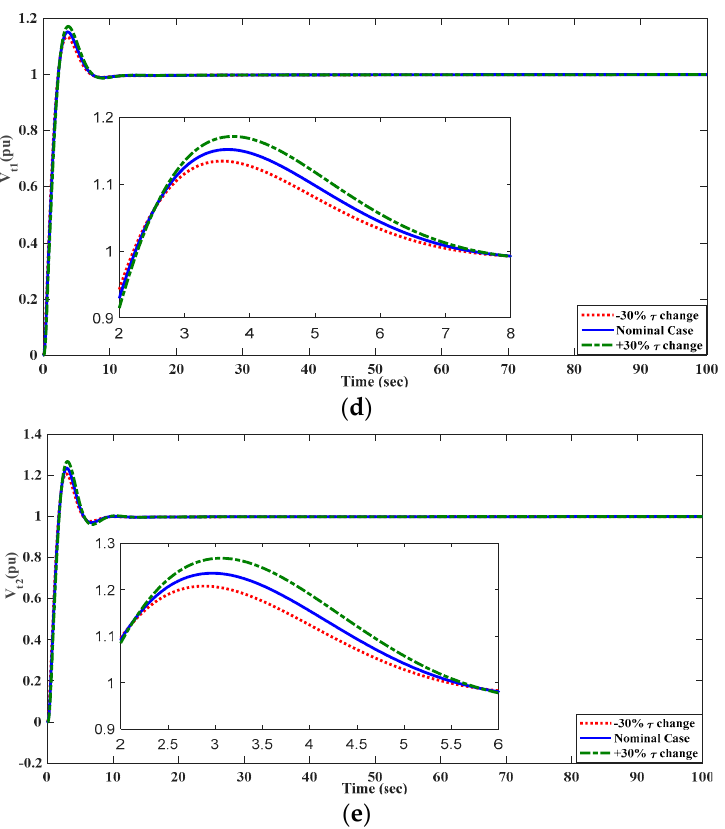
Figure 24. Simulation results: system dynamics for variation in time constants of the AVR system. ( a ) Δ f 1 ; ( b ) Δ f 2 ; ( c ) Δ P tie ; ( d ) Δ V t1 ; ( e ) Δ V t2.